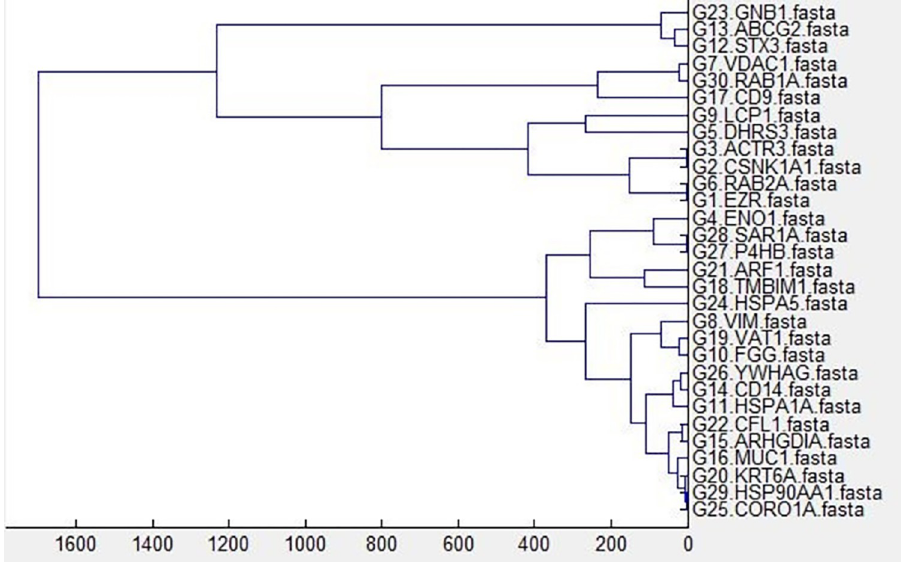
Fig 3. Average clustering based on discrete Fourier transform of bovine candidate gene DNA sequences.